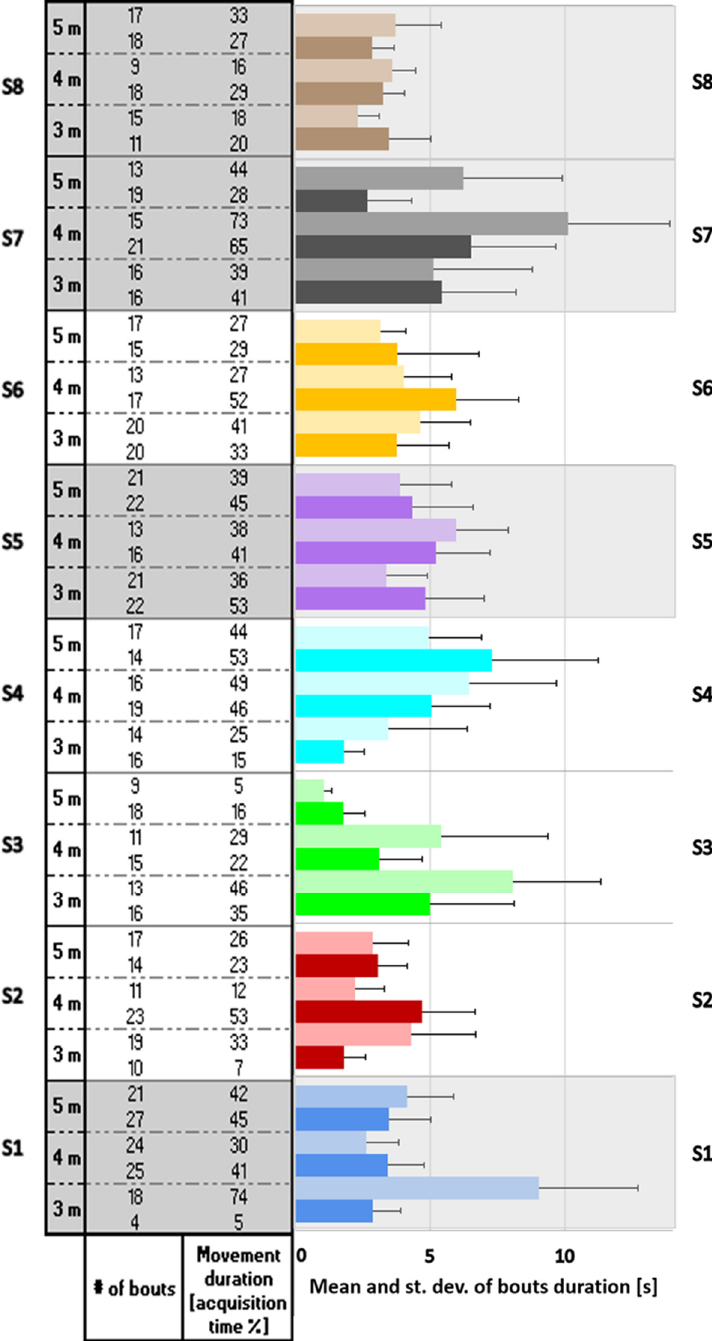
Figure 7. Mean and standard deviation of bouts duration for each infant at each timepoint (3, 4, and 5 months). The left side is the lighter color while the right side is the darker one. The number of bouts and the movement duration, calculated as percentage of the acquisition time, are reported in the table on the left. Subjects not suggesting atypical development are grayed.